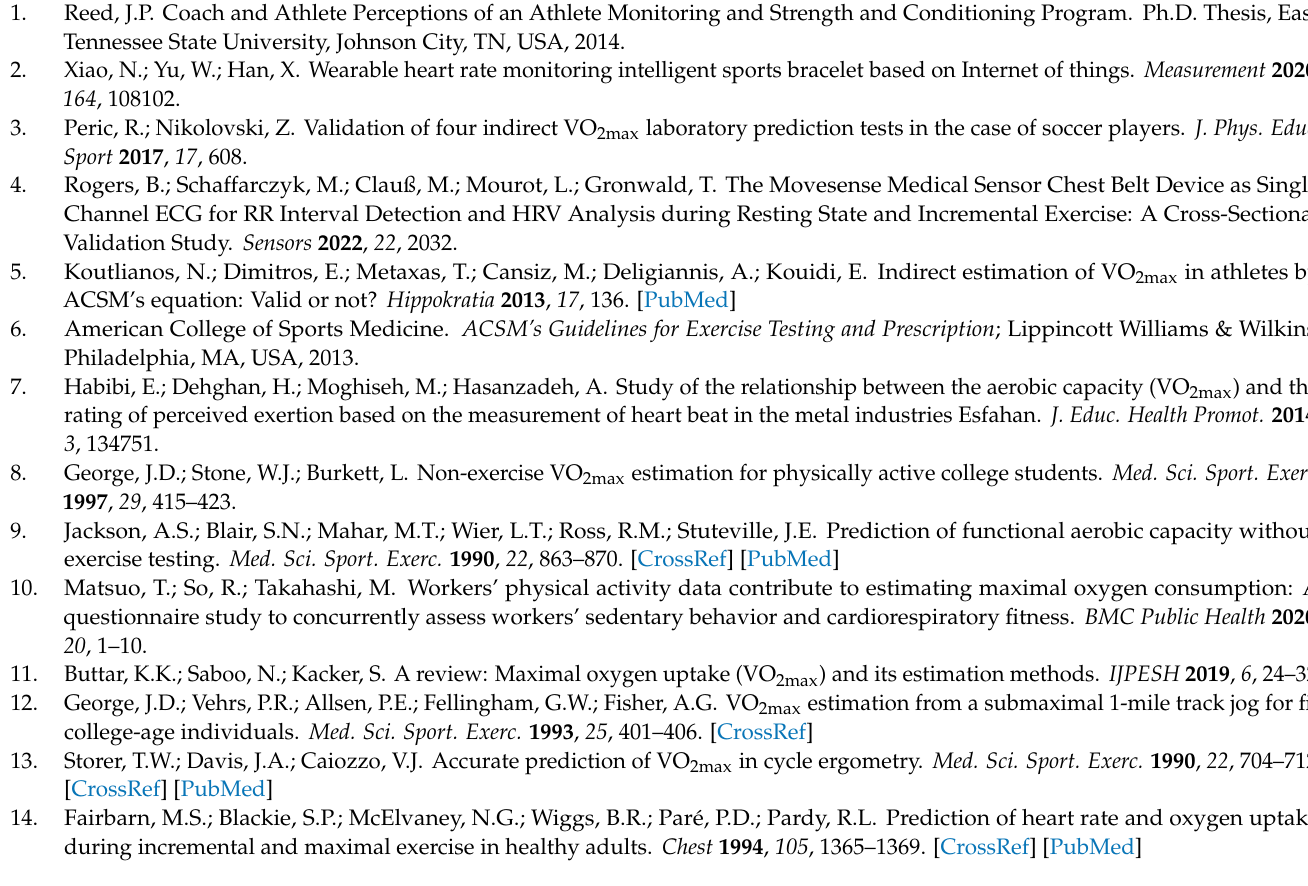
were 5.303 and 0.262, respectively. To help with the reproducibility of the results, the data were split into training and testing using the sklearn.model_selection.Kfold module with random_state set to a seed value of 5. This K-Folds cross-validator module provided indices to split the data into train/test sets and split the dataset into k consecutive folds. Each fold was then used once as validation while the k–1 remaining folds were used to train the model. Using the fixed seed for the random state ensured that indices obtained using random shuffles would be